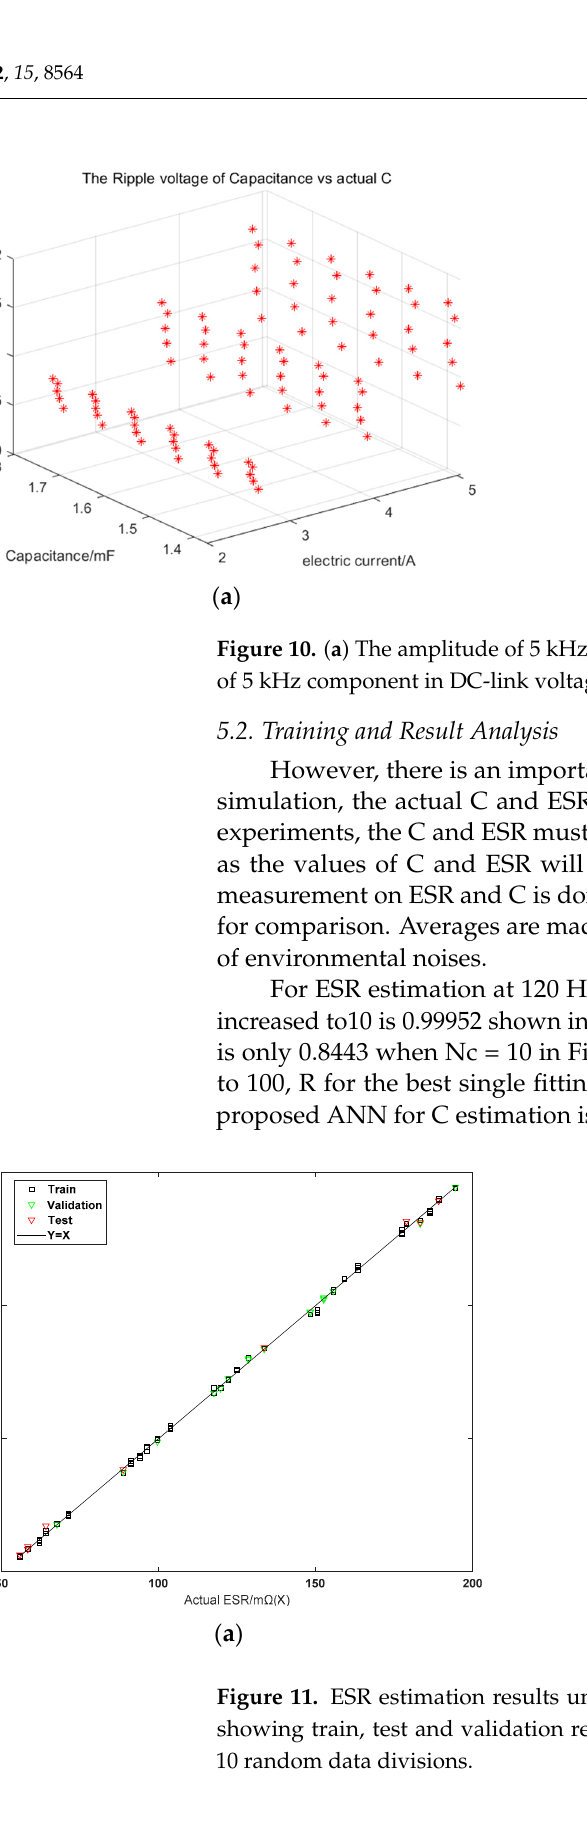
Figure 12. C estimation results under experiments by ANN ( a ) a best fitting showing train, test and validation results when Nc = 10; ( b ) cross validation showing PEs for 10 fittings under 10 random data divisions when Nc = 10; ( c ) a best fitting showing train, test and validation results when Nc = 100; ( d ) cross validation showing PEs for 10 fittings under 10 random data divisions when Nc = 100.